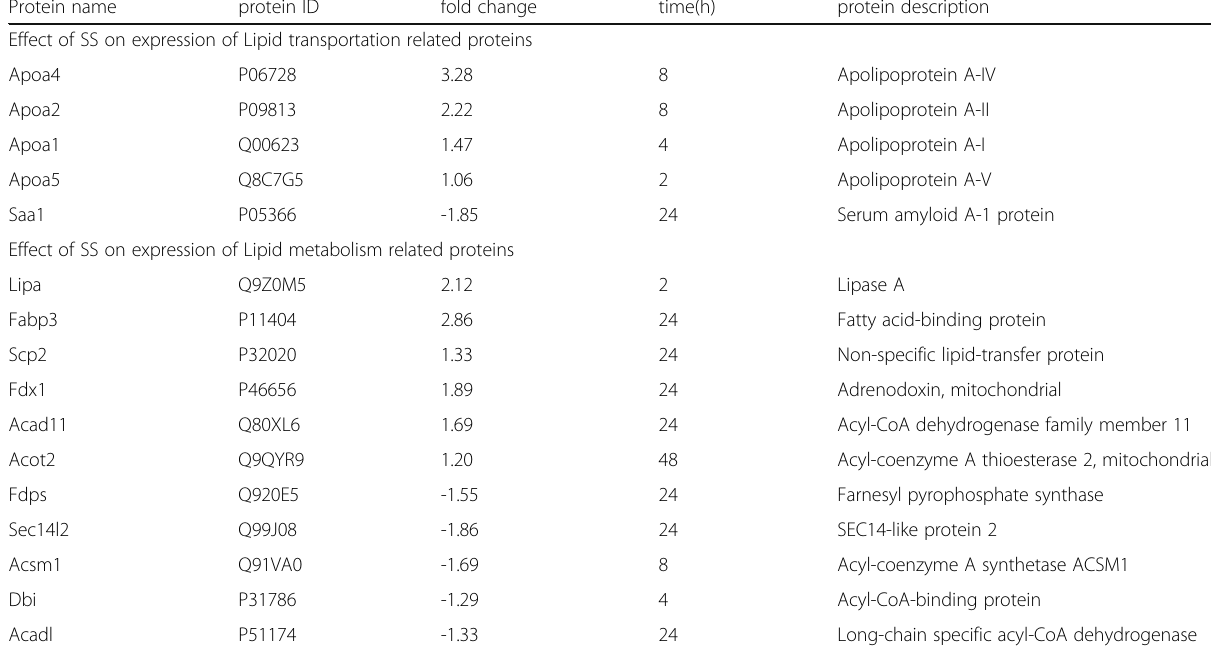
Table 1 Effects of SS on expression of lipid metabolism related proteins Protein